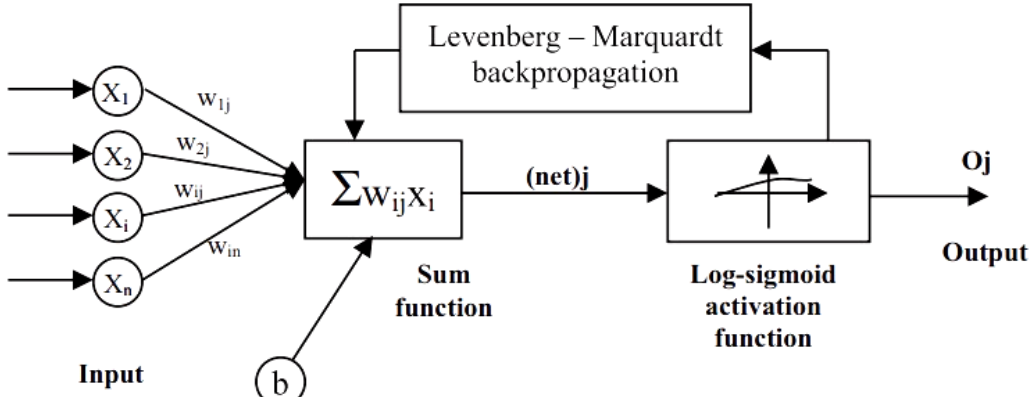
Fig. 3. Structure of Artificial Neural Network with 3